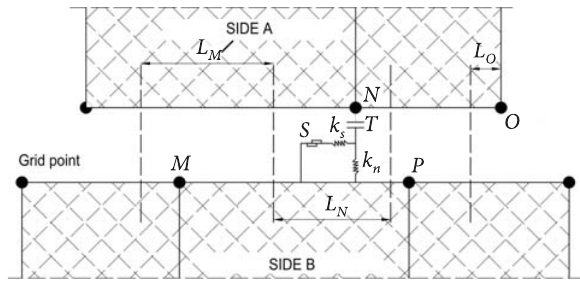
fig. 6. An interface element represented by sides A and B, connected by shear ( k s ) and normal ( k n ) stiffness springs: S – slider; T – tensile strength; L N – length associated with grid point N ; L M – length associated with grid point M ; L 0 – length associated with grid point O ; – – – denotes limits for joints segments (placed halfway petween adjacent grid points)